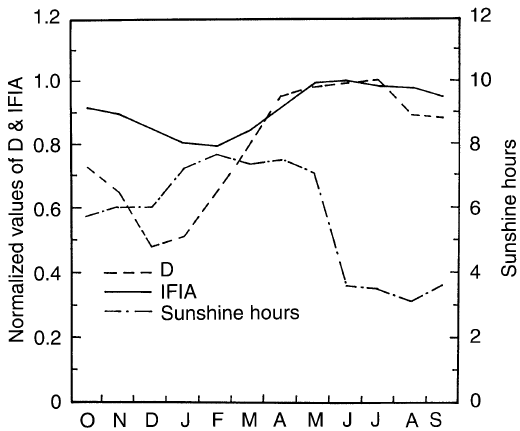
Fig. 7. Curves showing the sunshine hours, and normalized values of (1) diffuse radiation and (2) IFIA for Calcutta